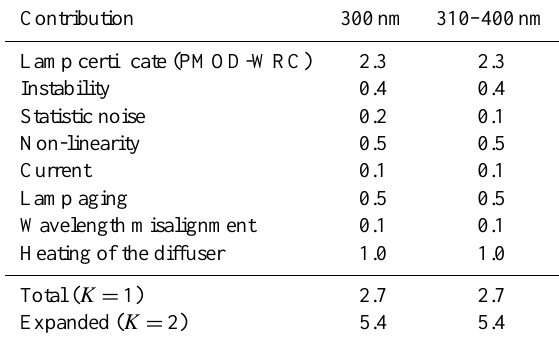
Table 3. Radiometric uncertainty (%) of the spectroradiometer. The total radiometer uncertainty is calculated as the squared sum of the different contributions. Coverage factor is marked with K